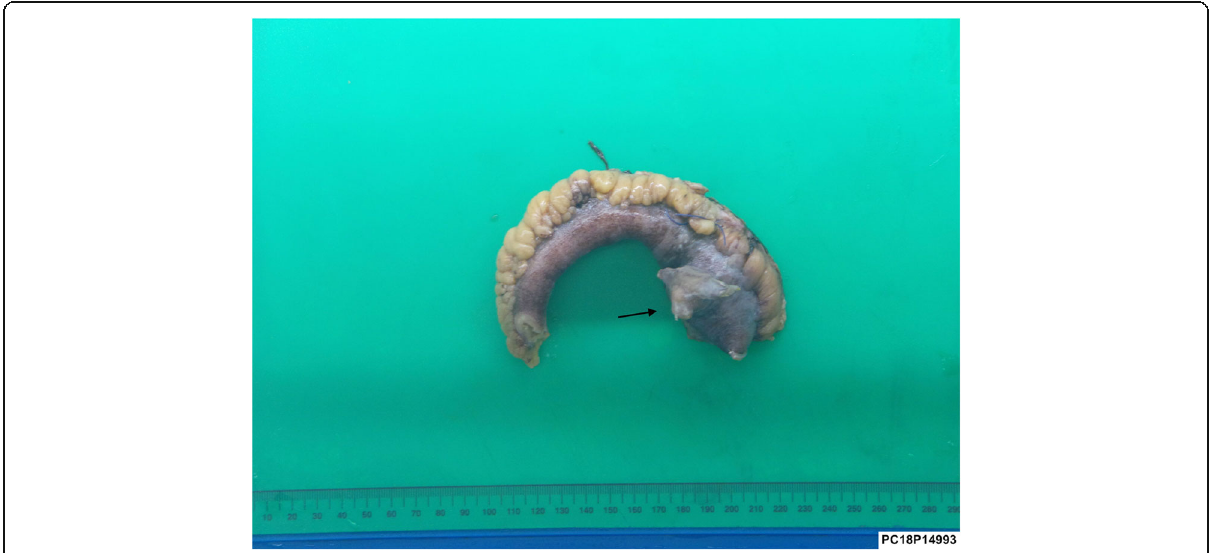
Fig. 4 Macroscopic view of the resected bowel containing MD with sign of perforation by chicken bone (arrow)